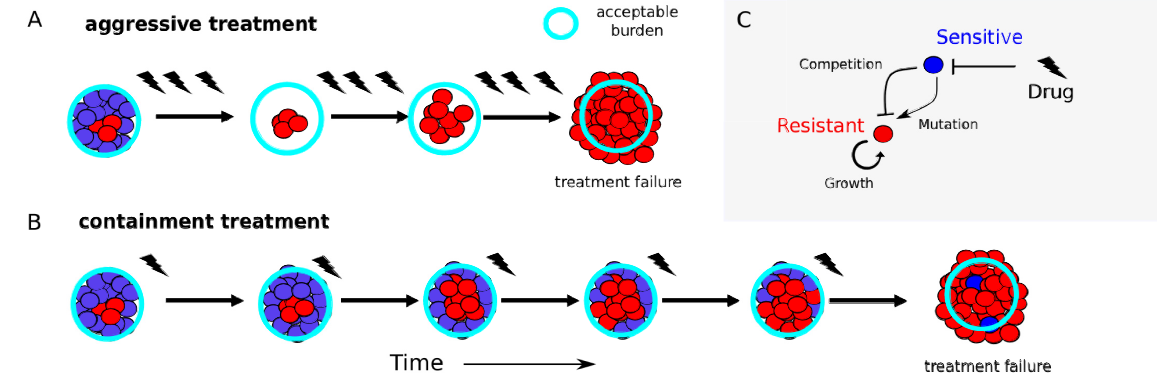
Fig 1. Containment strategies may leverage competition to extend time below treatment failure threshold. (A) Aggressive treatment uses high drug concentrations (lightning flashes), which eliminates sensitive cells (blue) but may fail when resistant cells (red) emerge and the population exceeds the failure threshold (“acceptable burden”, light-blue circle). (B) Containment strategies attempt to maintain the population just below the failure threshold, leveraging competition between sensitive (blue) and emergent resistant (red) cells to potentially prolong time to failure. (C) Schematic of potential feedback between growth processes in mixed populations. Drug (lightning flash) inhibits sensitive cells (blue), which in turn inhibit resistant cells (red) through competition but may also contribute to the resistant population via